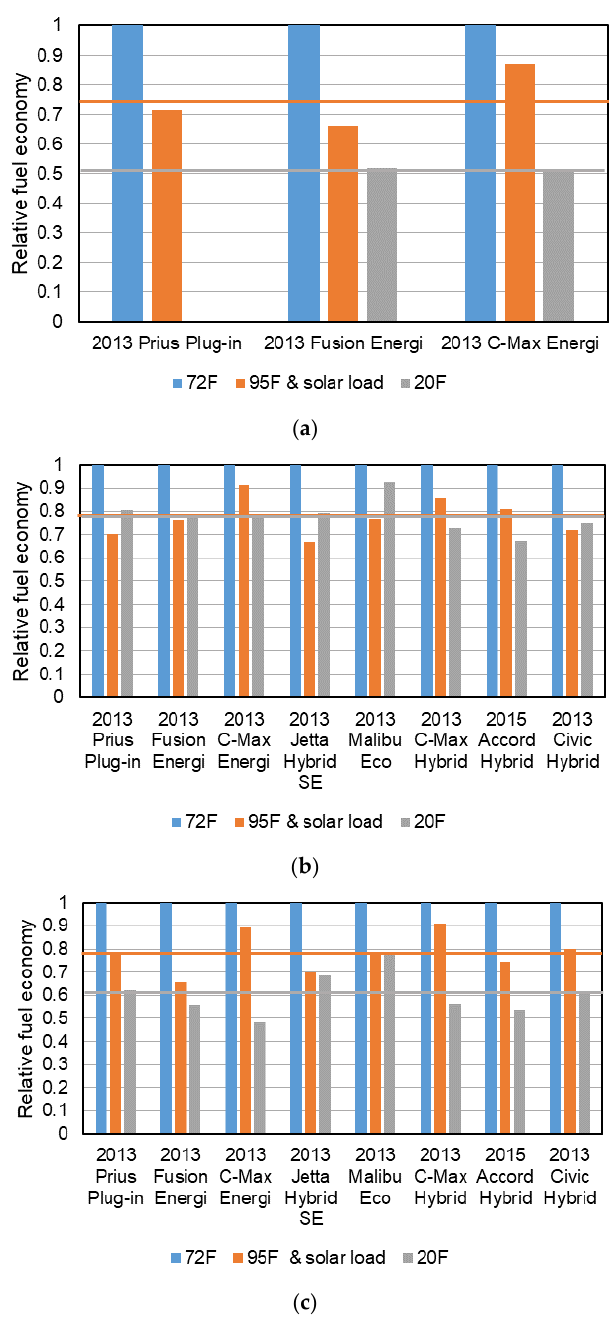
Figure 6. Effect of ambient conditions on PHEV and HEV fuel economy. Orange and gray lines represent average values for MPGe at 95 °F with solar load (850 W/m 2 ) and 20 °F respectively. The fuel economy was over urban driving dynamometer schedule (UDDS) cycle at ( a ) blended CD mode with warm start ( b ) CS mode with warm start ( c ) CS mode with cold start.